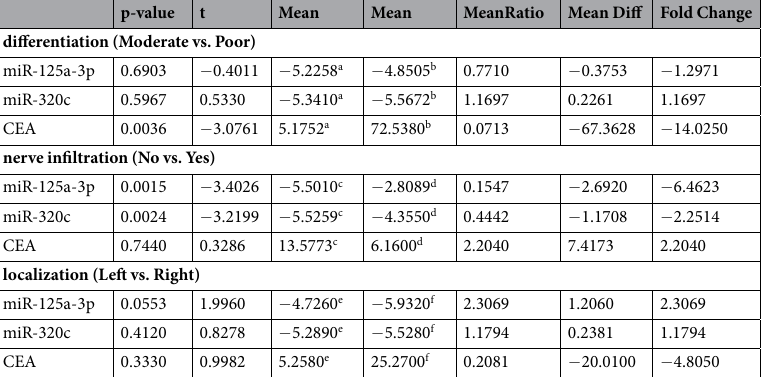
Table 4. Correlation between the clinical parameters and the markers. a Mean of moderate, b mean of poor, c mean of without infiltration, d mean of with infiltration, e mean of left colon cancer, f mean of right colon